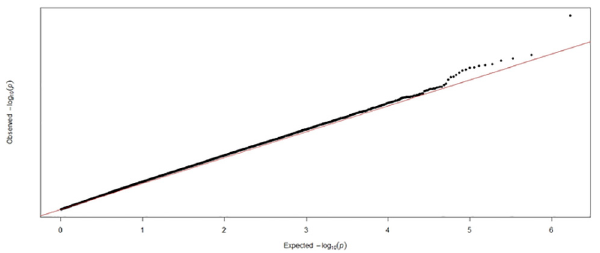
Fig 2. Quantile-quantile plot of the SNPs tested in the pooled DNA association stage.